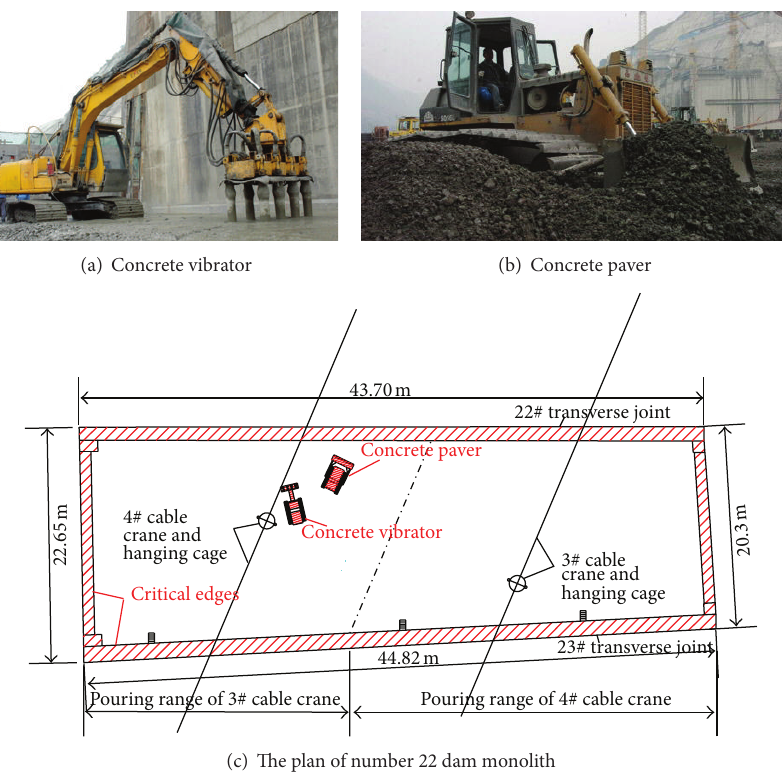
Figure 7: Concrete pouring hazards in number 22 dam monolith.